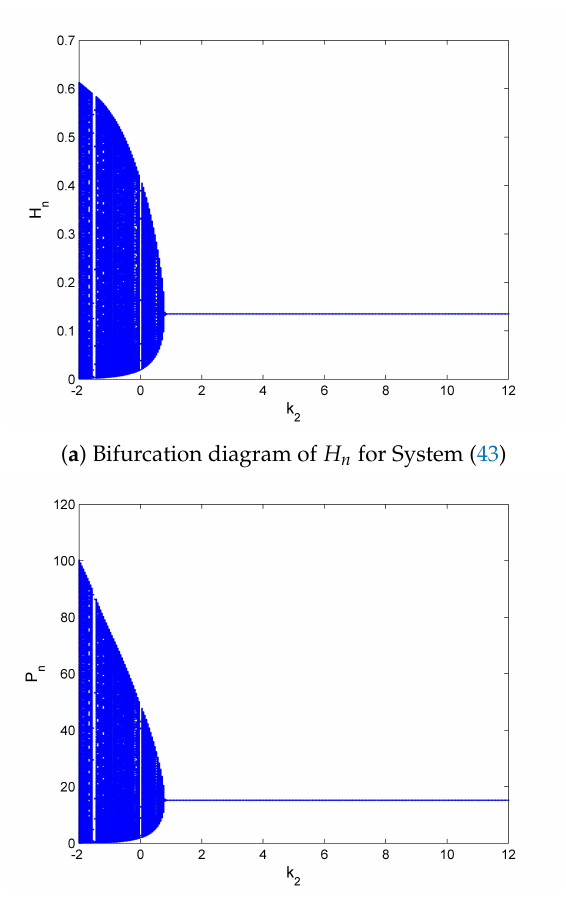
Figure 6. Bifurcation diagrams for the controlled System (43) with k 1 = 1, k 2 ∈ [ − 2,12 ] and initial conditions ( H 0 , P 0 ) = ( 0.13,15 )